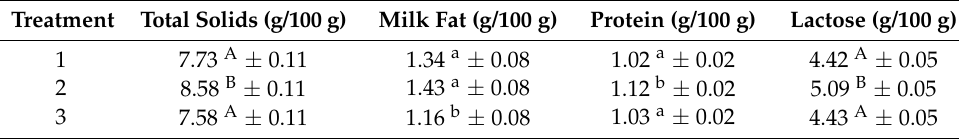
Table 2. The composition of whey obtained after Liˇcki škripavac cheese production regarding different type of cheese milk standardization (least square means ± standard errors). Treatment